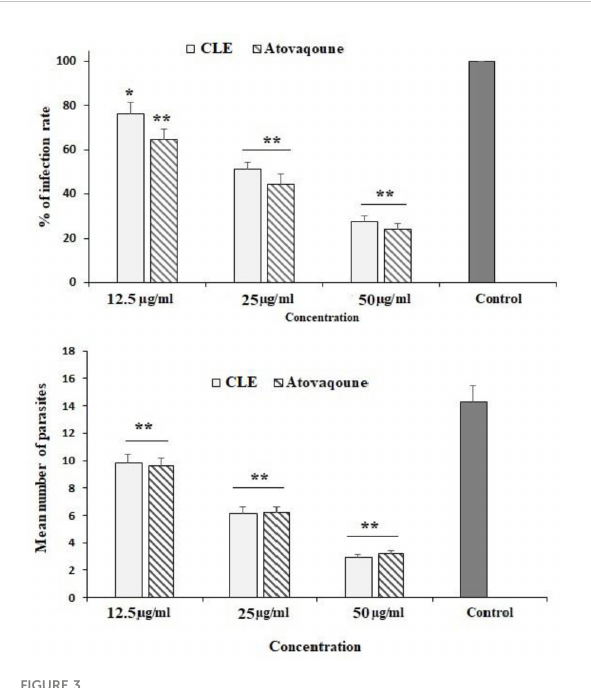
FIGURE 3 The infection rate of the Vero cells infected with Toxoplasma gondii tachyzoites after exposure to Curcuma longa essential oil (CLE) at 12.5, 25, and 50 µg/ml for 24 h. The intracellular replication of T. gondii in infected Vero cells after treatment with various concentrations of CLE. Data are expressed as the mean ± SD (n = 3). *p < 0.05; **p <